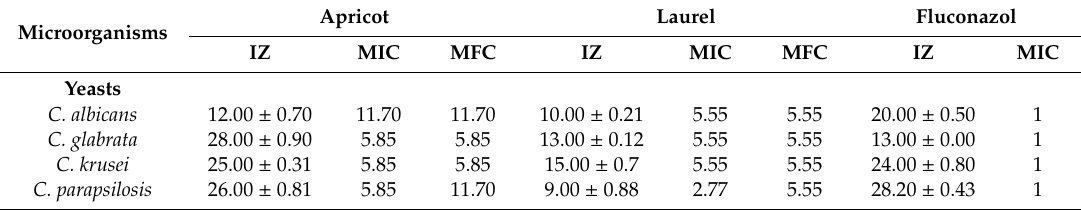
Table 3. Inhibition zone diameters, MIC and MFC of essential oils from apricot ( P. armeniaca ) and laurel ( L. nobilis ) leaves against yeasts using the disc di ff usion and micro-well dilution assays. Apricot Microorganisms